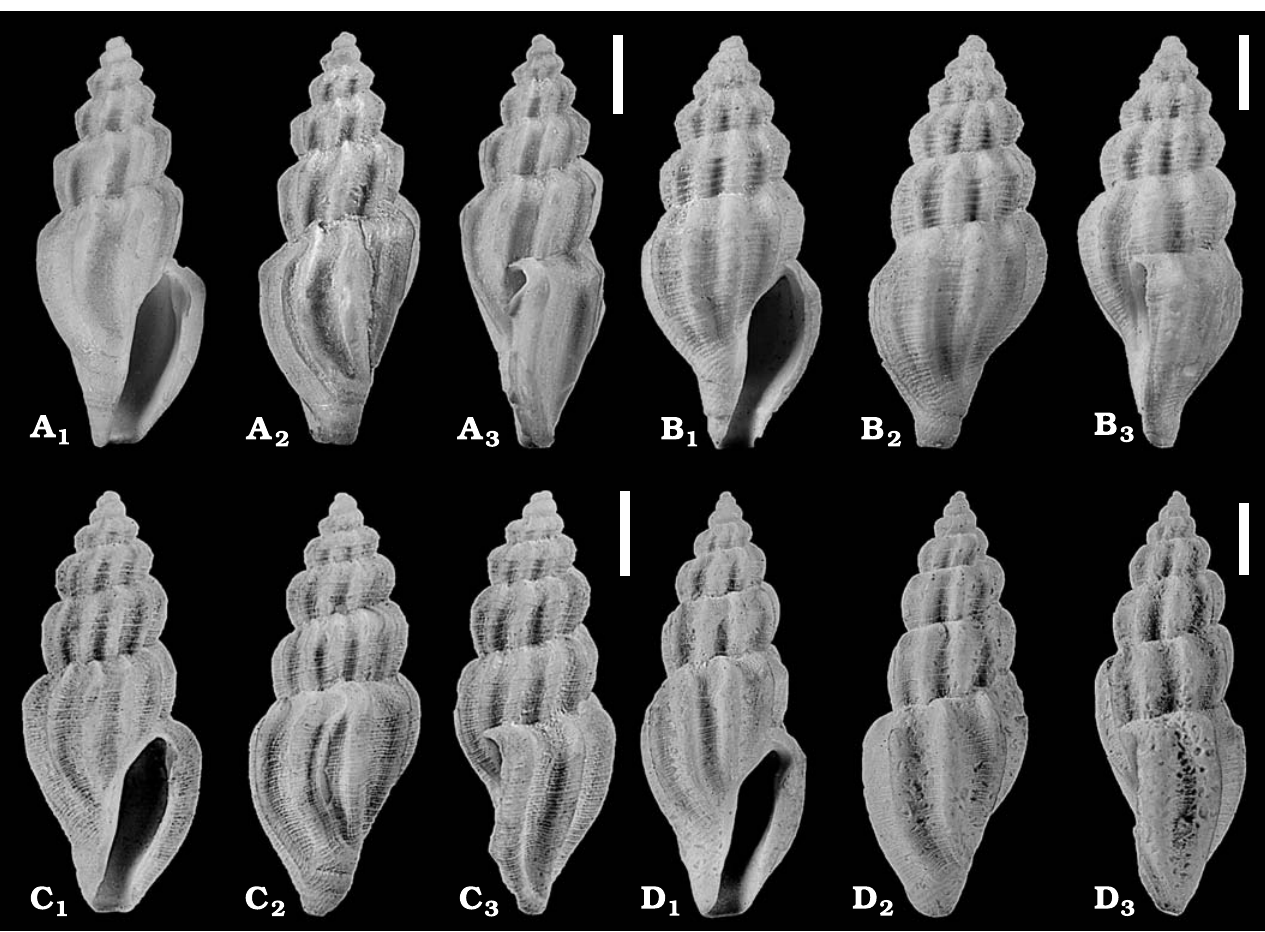
Fig. 3. Photomicrographs of holotype shells of new conoidean gastropods from early Serravallian of western Ukraine, Varovtsi (A–C) and Velyka Levada (D). A . Mangelia angulicosta sp. nov., MGGC-24505. B . Mangelia larga sp. nov., MGGC-24507. C . Mangelia pseudorugulosa sp. nov., MGGC-24509. D . Mangelia odovychenae sp. nov., MGGC-24511. Views: A 1 − D 1 , apertural; A 2 − D 2 , dorsal; A 3 − D 3 , lateral. Scale bars 1